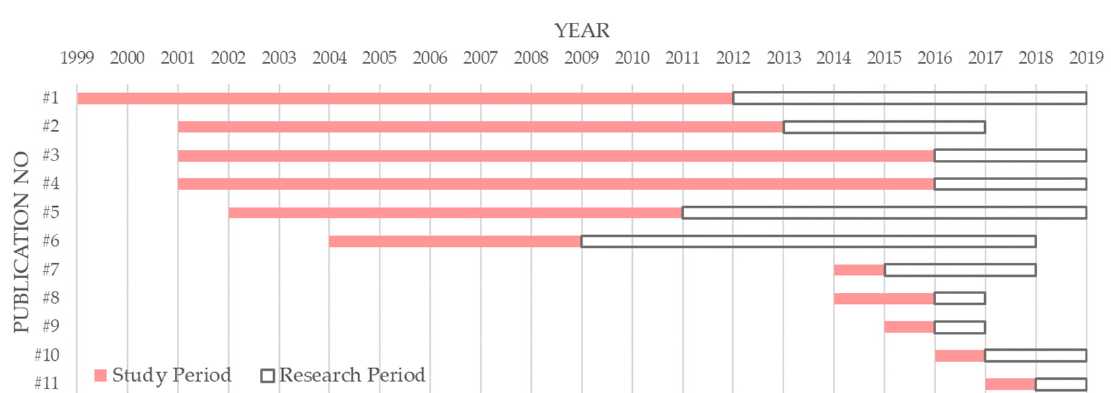
Figure 12. Study period and research period statistics of publications with ‘PM 25 ’ or ‘PM 2.5 ’ as keywords focusing on China.